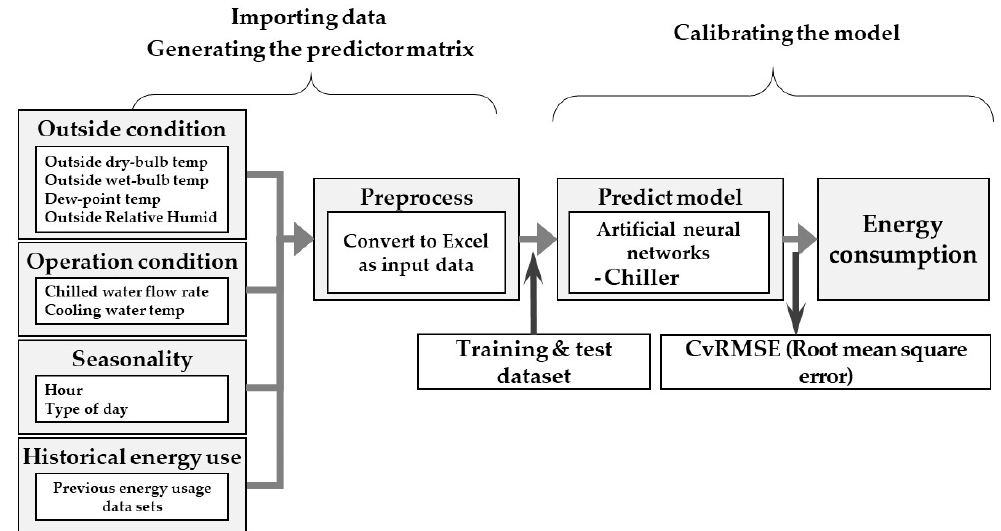
Figure 2. Schematic diagram of the predictive model of chiller energy consumption using the artificial neuron network (ANN) model.